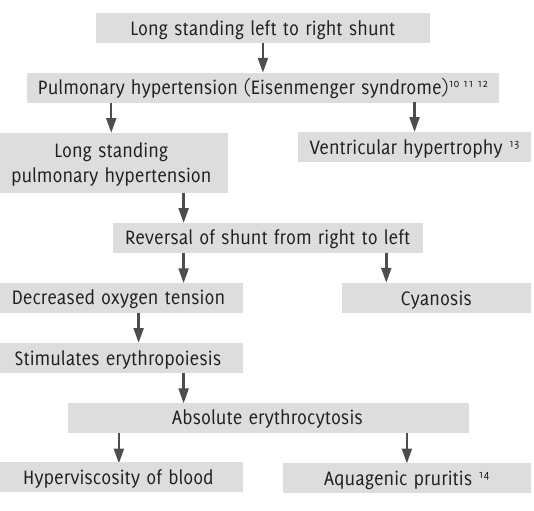
Figure 2. X-ray Chest Posteroanterior View Showing Cardiomegaly [(A+B)/C = 0.54, A= 3.28cm, B = 6.83cm, C = 18.52cm]